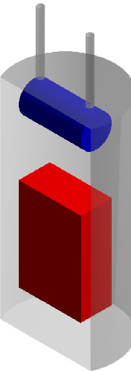
Figure 4. Geometry of the reactor for supercritical adsorption.